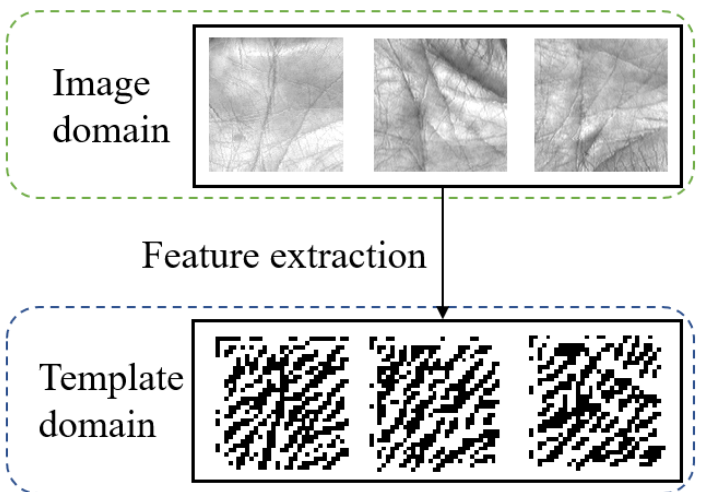
Figure 1. The two domains in biometric systems.